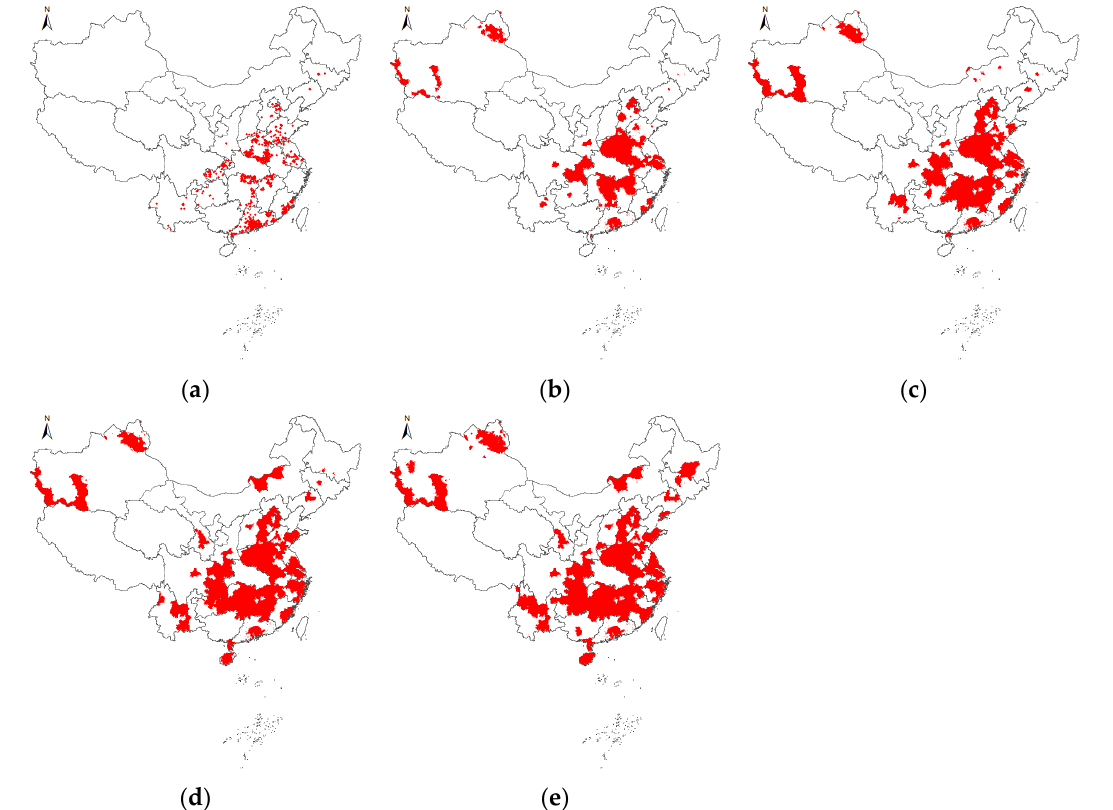
Figure 10. COVID-19 spread under no government control. ( a ) 6 February 2020 (actual data); ( b ) 16 February 2020 (simulated data); ( c ) 26 February 2020 (simulated data); ( d ) 7 March 2020 (simulated data); ( e ) 20 March 2020 (simulated data).